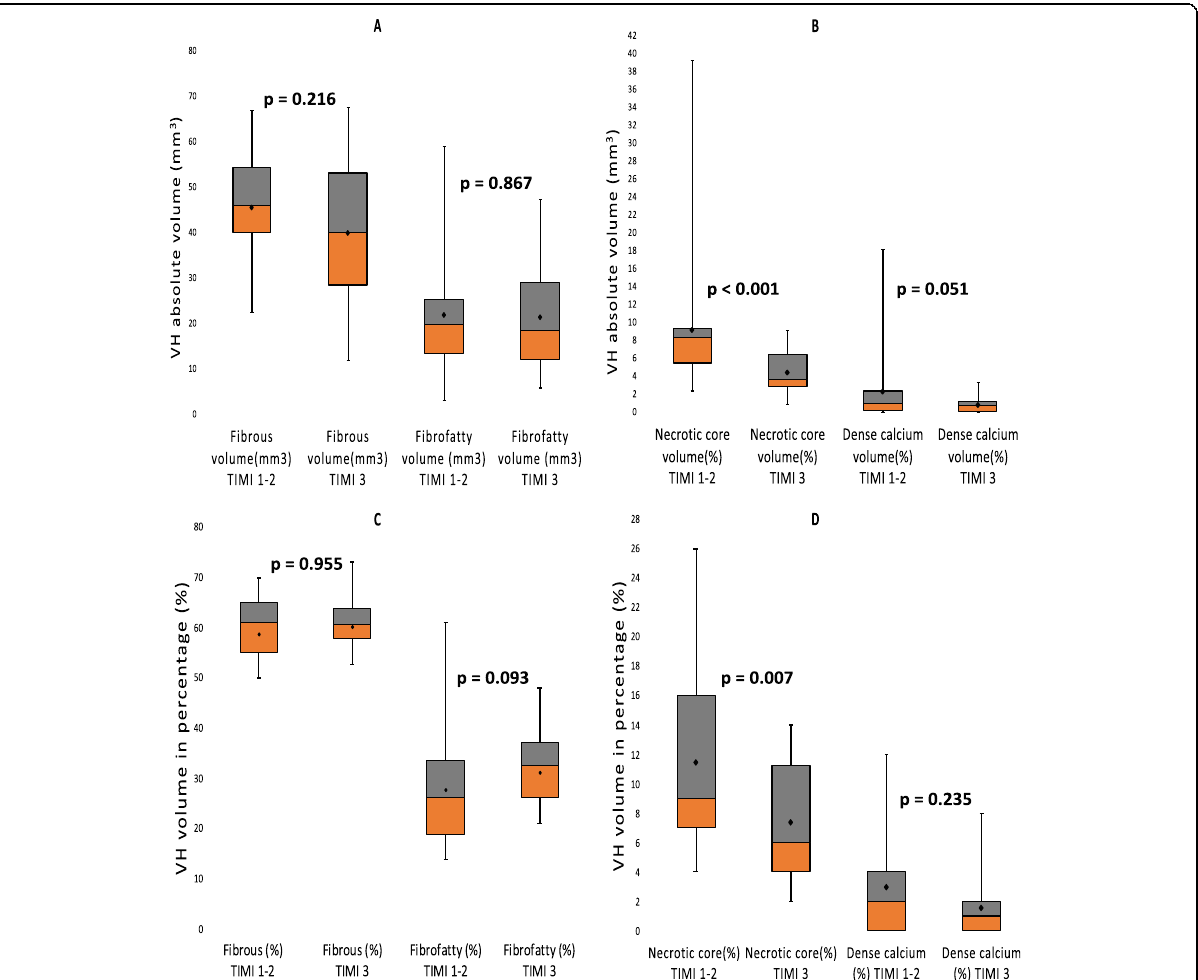
Fig. 2 The virtual histology plaque components in TIMI 1 – 2 and TIMI 3 groups over the segment. a and b represents the absolute volumes of the plaque components and c and d represents the relative plaque